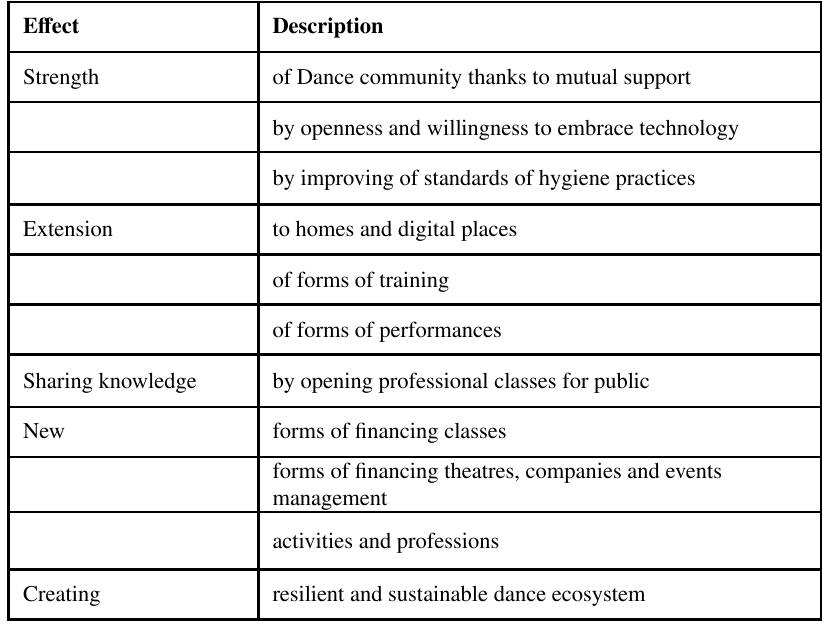
Table 1. First responses to the pandemic in the world of